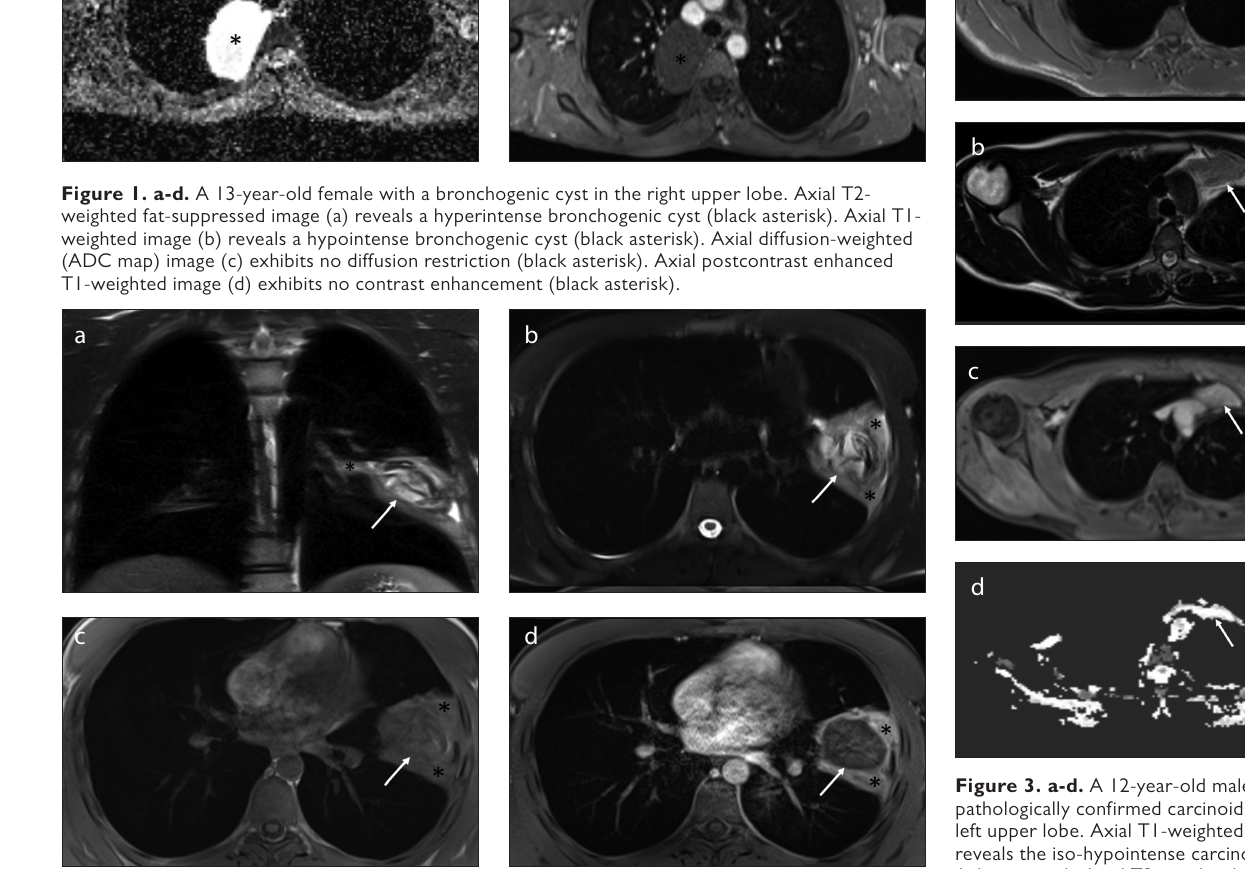
Figure 2. a-d. A 15-year-old male with a ruptured hydatid cyst in the left lower lobe anteromedial segment. Coronal T2-weighted (a), axial T2-weighted fat-suppressed (b), and axial T1-weighted (c) images reveal the hydatid cyst (white arrow) and intense inflammation secondary to rupture (black asterisk). Axial postcontrast-enhanced image (d) reveals no contrast enhancement in the hydatid cyst lesion (white arrow) and distinct contrast enhancement in the inflammation secondary to rupture (black asterisk).